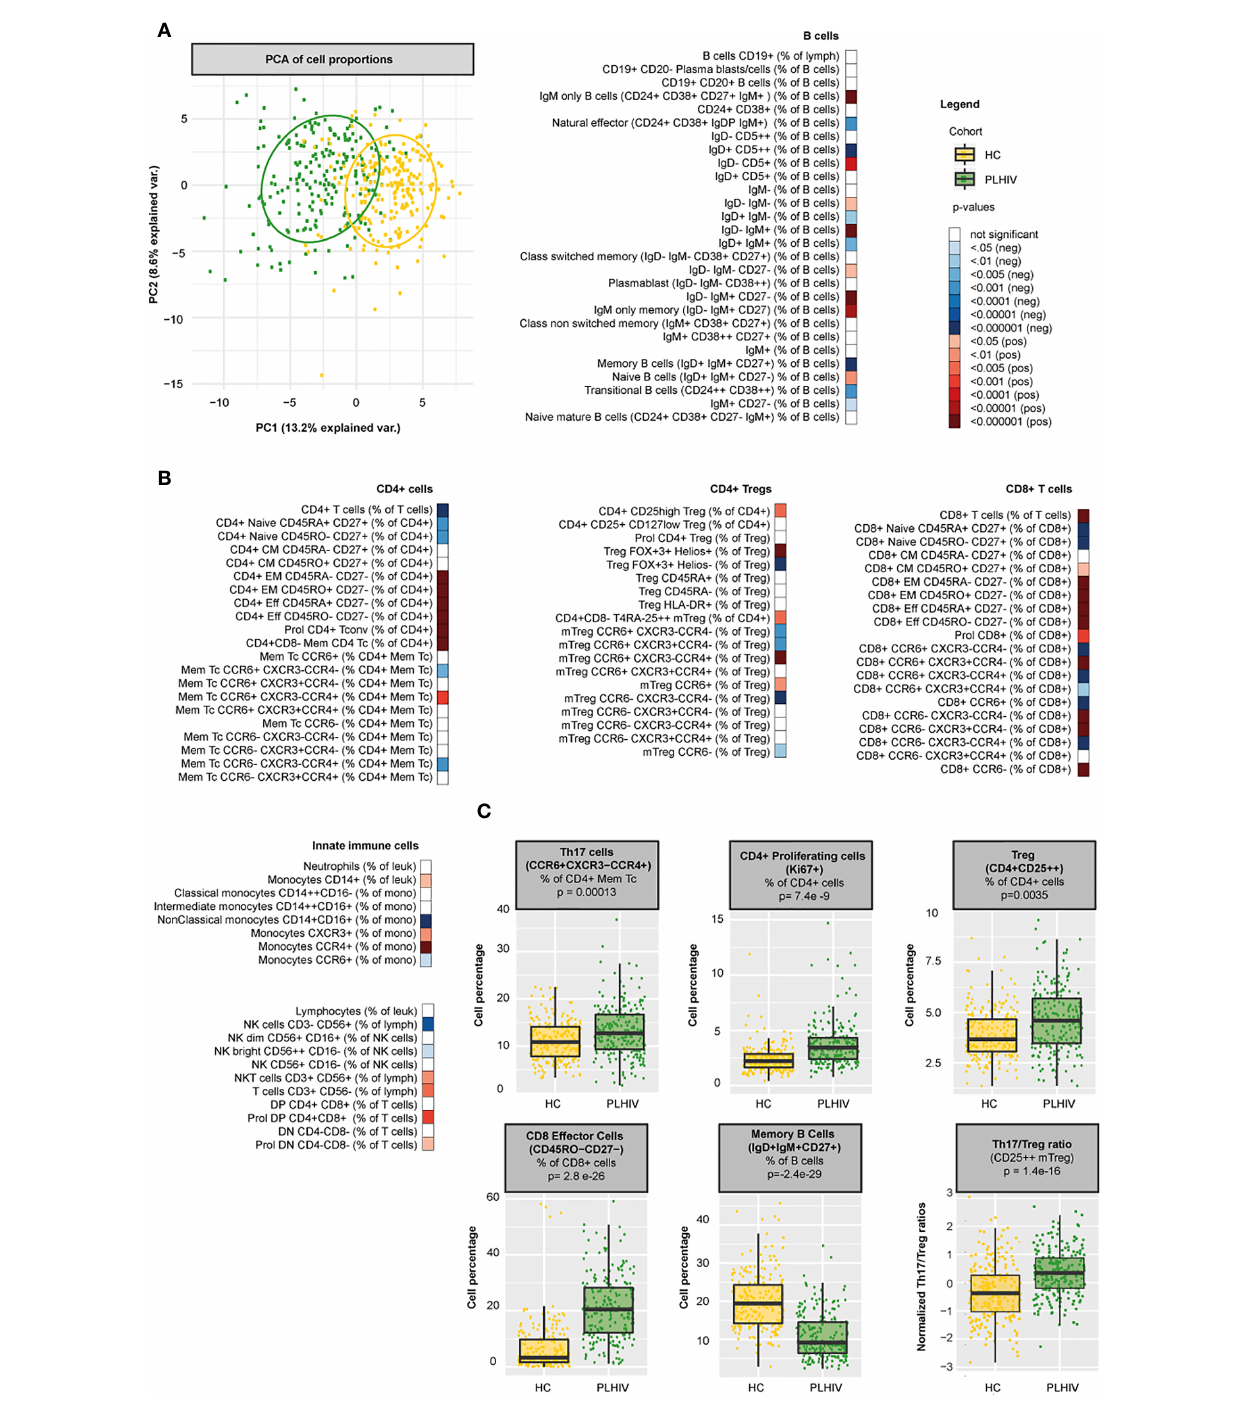
FIGURE 1 | Differences in WBC percentages between PLHIV and healthy individuals (A) Principal component biplot showing standardized variance for the two principal component of all WBC subsets. The ovals represent the different cohorts. (B) Differences in WBC percentages (n=108 WBC subsets) between PLHIV (n=211) and healthy controls (n=56) (C) Boxplots showing examples of cohort differences in cell percentages and Th17/Treg ratios (Treg identi fi cation marker CD25++). Inverse-rank transformed data were analyzed using multiple linear regression and adjusted for age, sex, sampling time, and season. For color coding of the FDR-adjusted p-values see